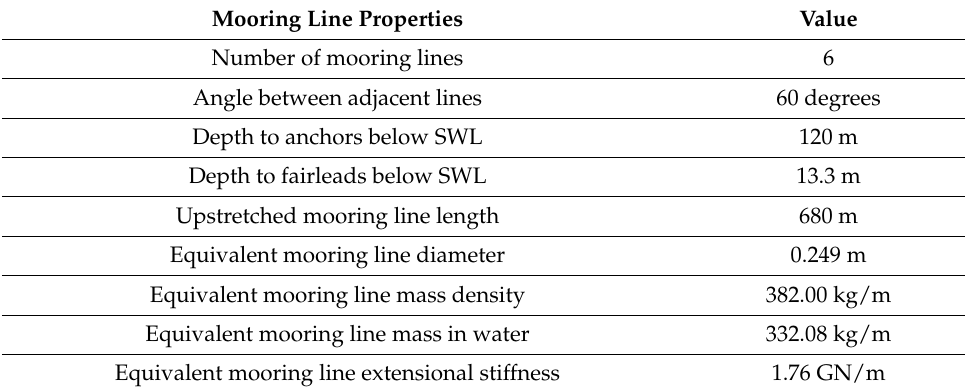
Figure 2. Mooring line configuration. Table 4. Description of mooring line